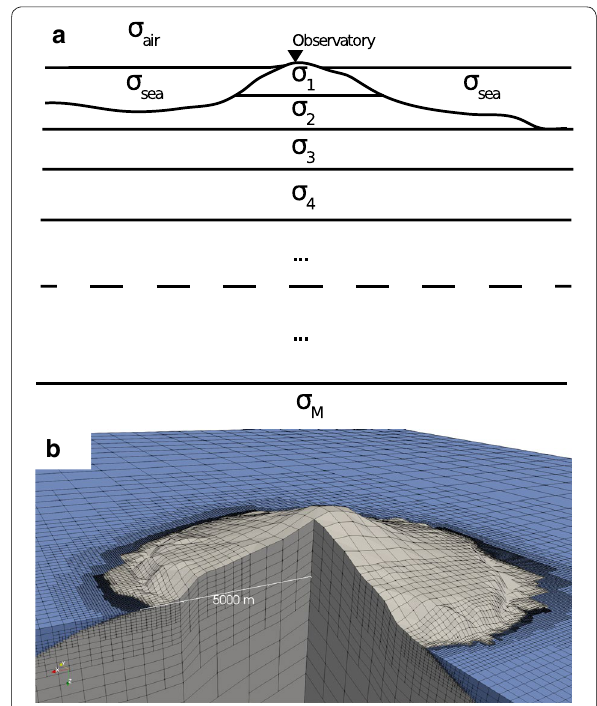
Fig. 1 Short title: Model parameterization Detailed legend: a Sketch of the adopted model parameterization. The σ 1 , ... , σ M conductivity values denote the unknowns, which are estimated using data from the observatory. Note that the bottom layer extends to infinity. b Example of a locally refined mesh for the Tristan da Cunha island with topography-conforming